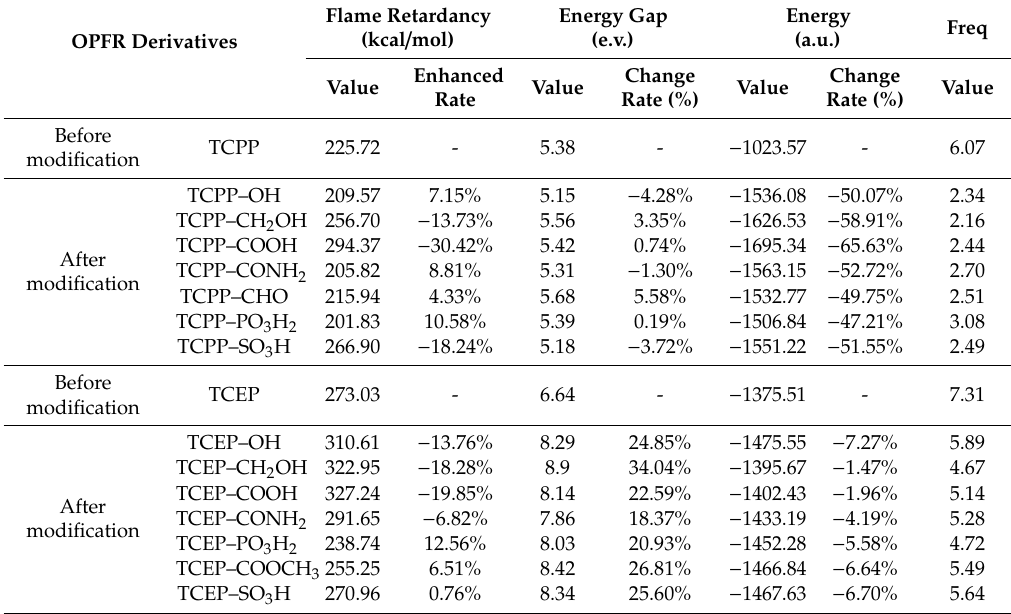
Table6. Datestatisticsofflameretardancy, energyvalue,